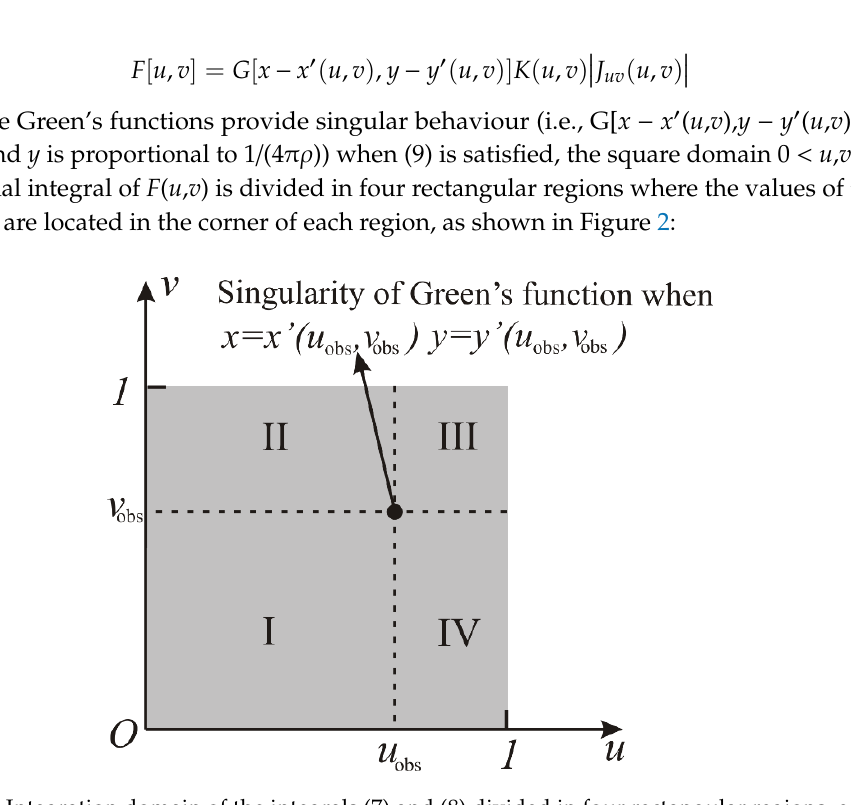
Figure 2. Integration domain of the integrals (7) and (8) divided in four rectangular regions, each of which with the singular behavior of the integrand located in a corner of each region.